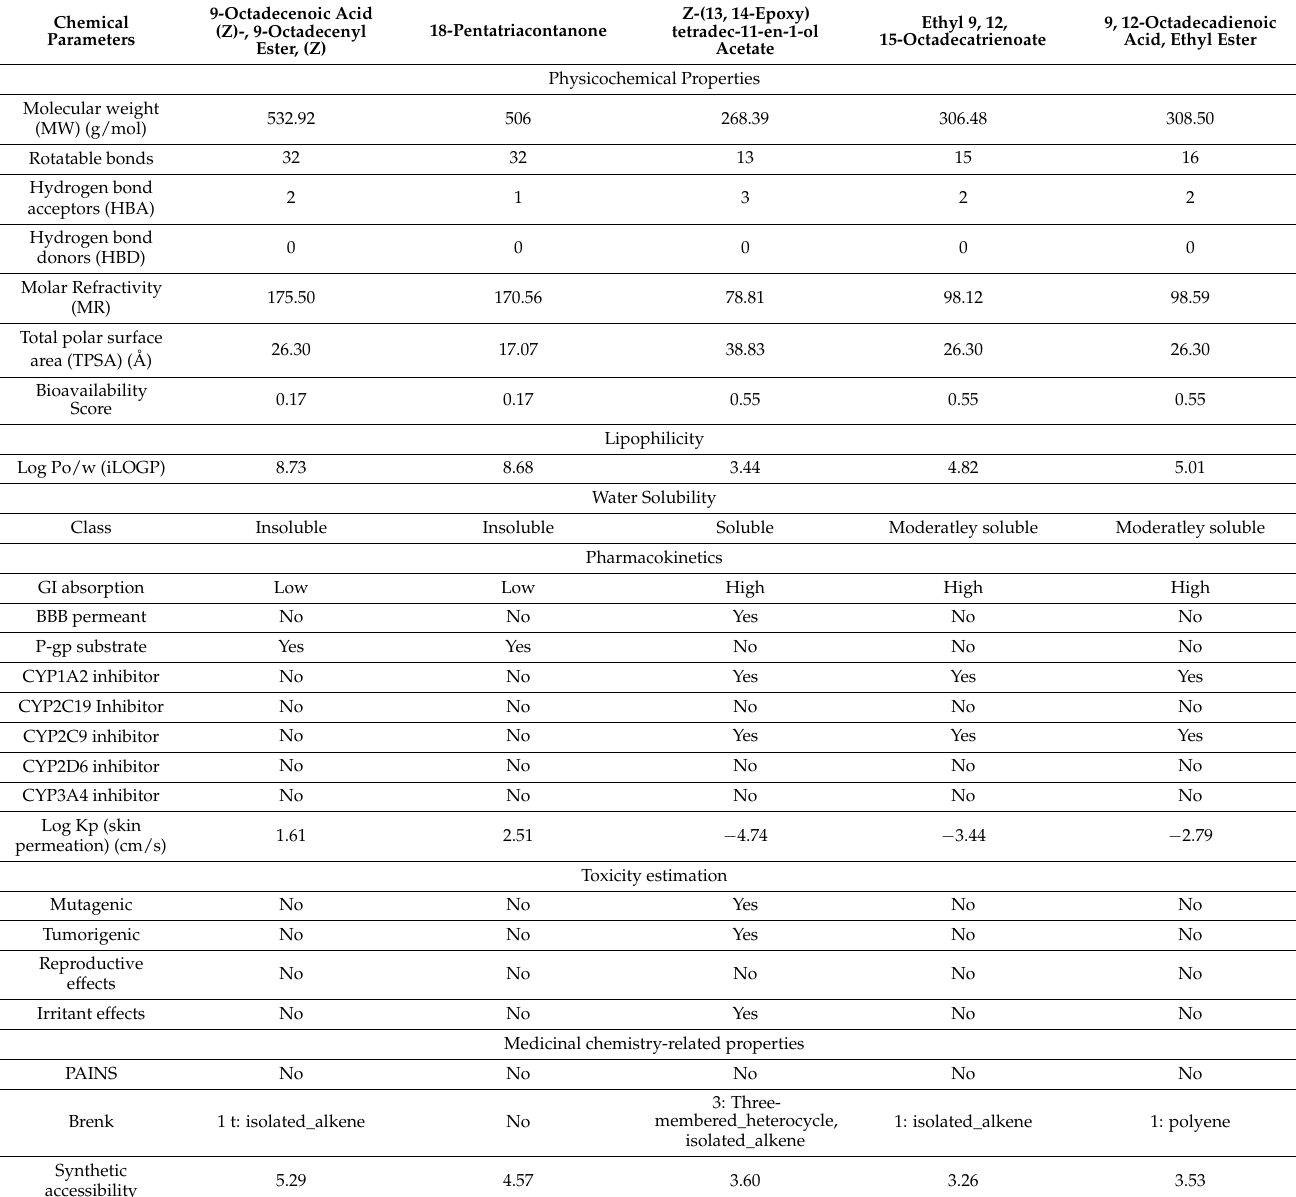
Table 6. Computational protocols applied for ADMET